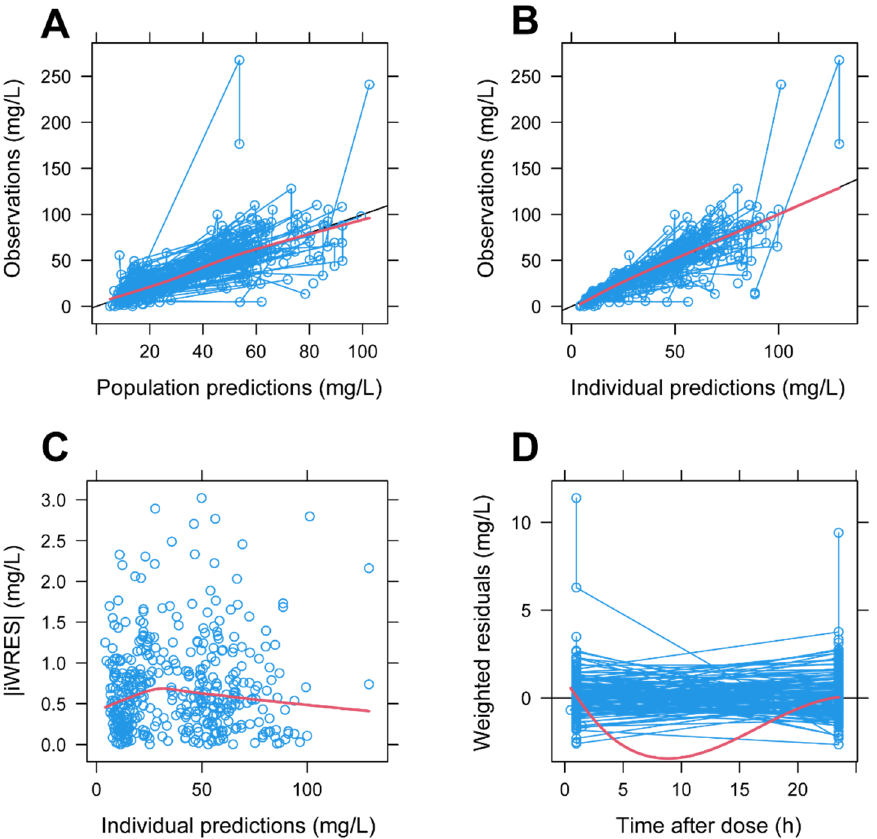
Figure 2. Goodness-of-fit plots of the final model: ( A ) relationship between observations and population prediction of daptomycin plasma concentrations; ( B ) relationship between observations and individual prediction of plasma concentrations; ( C ) distribution of absolute values of individual weighted residuals (|iWRES|) versus individual predictions of daptomycin plasma concentrations; ( D ) distribution of weighted residuals versus time after dose. Blue lines and empty circles: daptomycin plasma concentrations for every enrolled patient. Red lines: mean of the observed concentrations (panels ( A ) and ( B )) or Loess lines (panels ( C ) and ( D )). Black lines: lines of identity. Antibiotics 2022 , 11 , x FOR PEER REVIEW